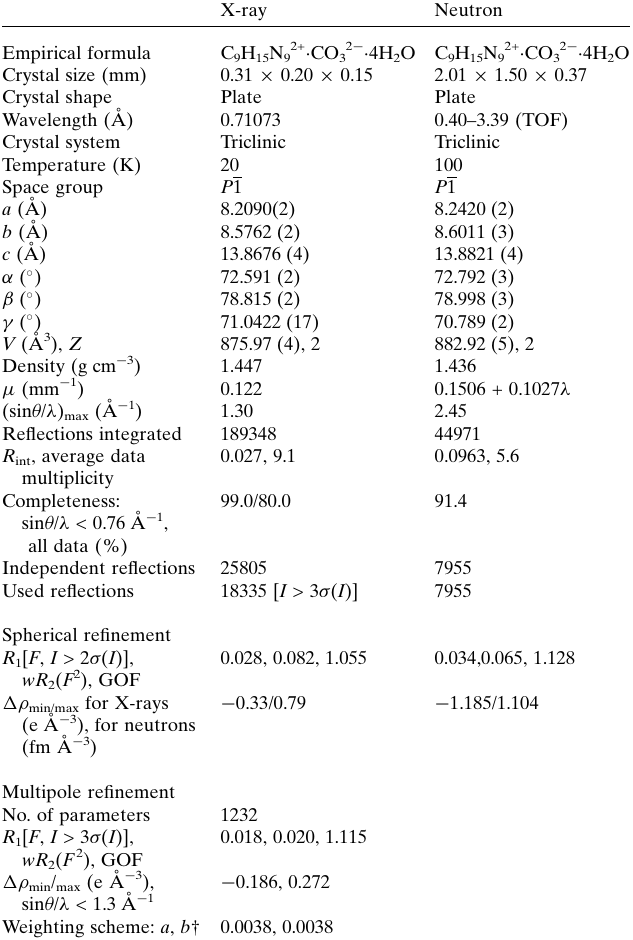
Table 1 Experimental details. CIFs for both experiments are provided in the supporting